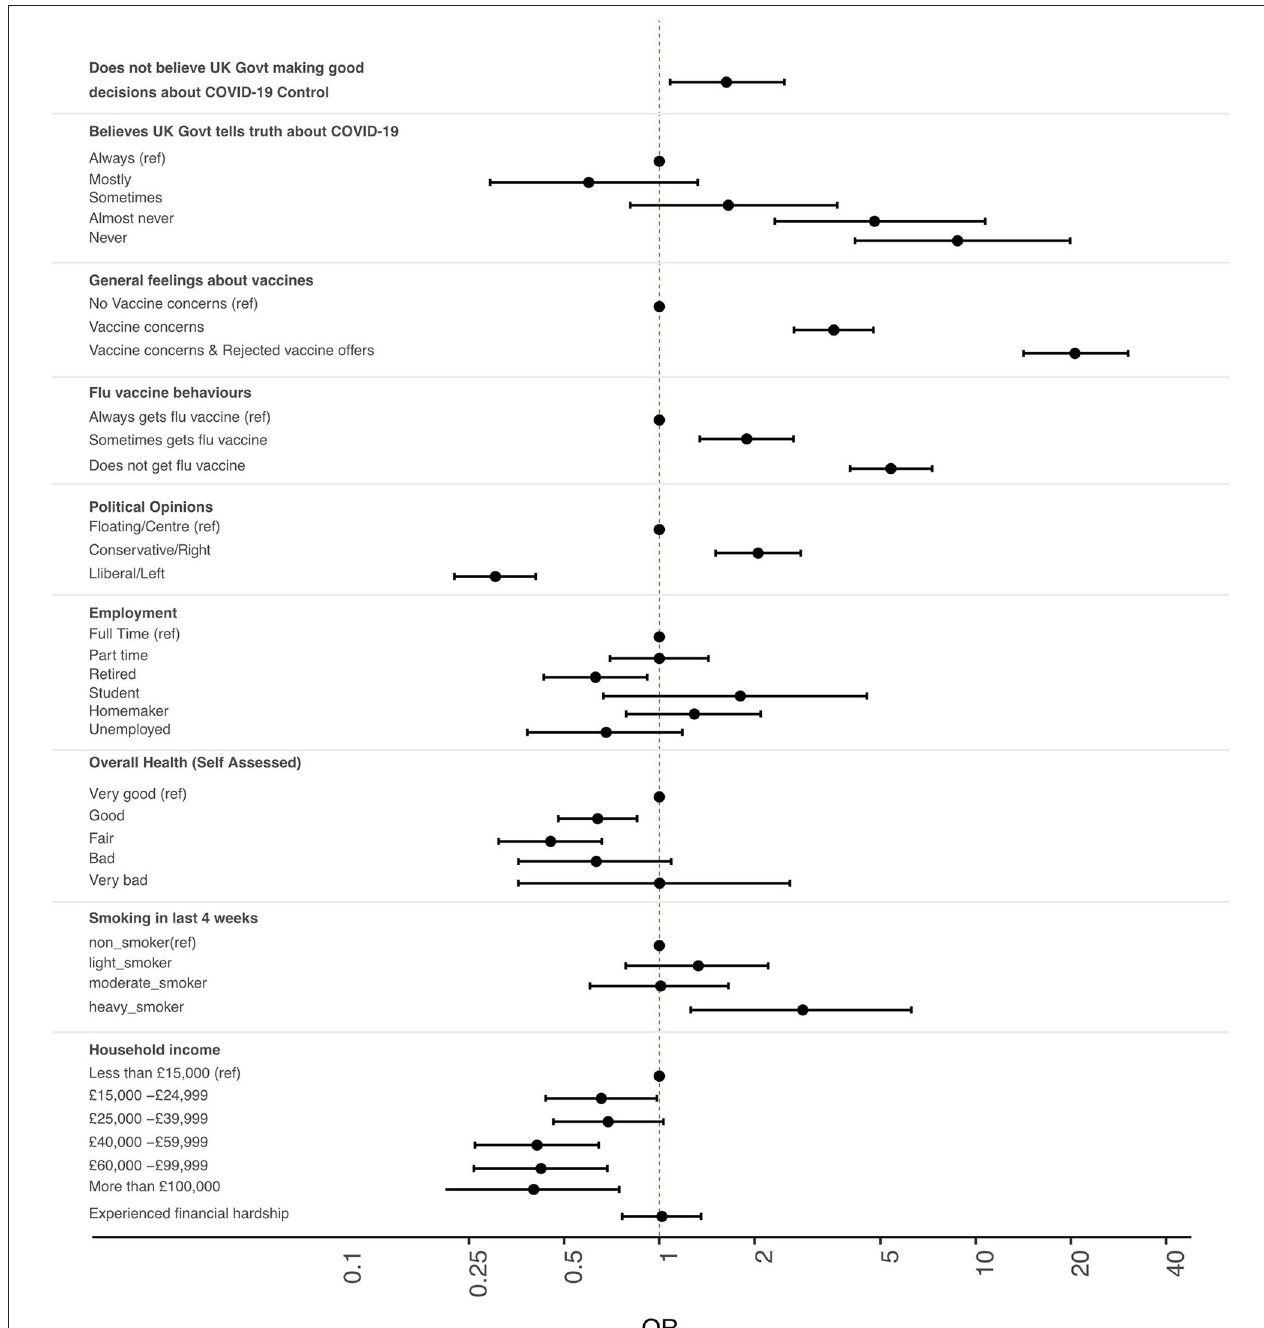
FIGURE 1 | Intention to refuse offers of COVID-19 vaccination among members of the UK public. Odds ratio (OR) estimates [points] and 95% confidence intervals [solid lines] indicate relative intention to refuse vaccine. ORs above 1.00 indicate increased OR of rejecting vaccines. Values below 1.00 indicate increased intention to accept vaccines. All ORs are fully corrected for other covariates. Covariates that had no significant association with intention to vaccinate are not shown, but are fully described in Table 1